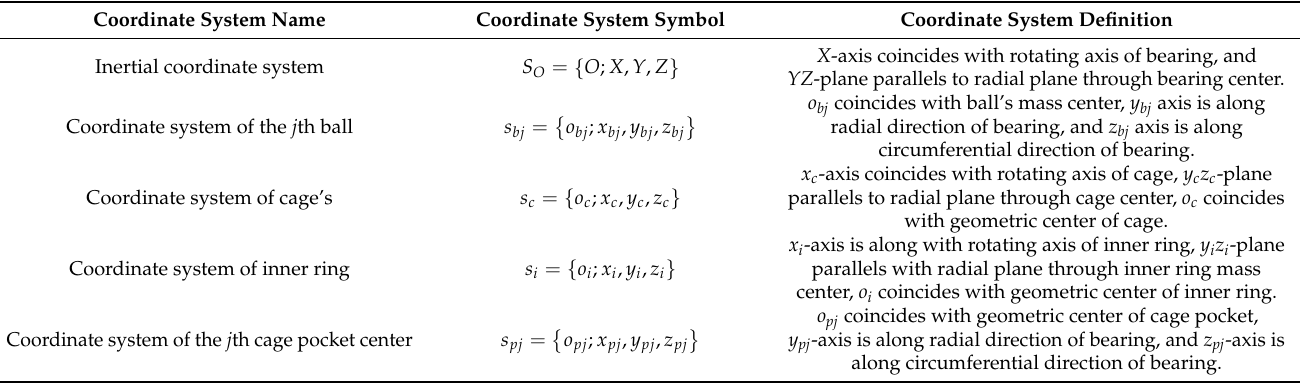
Figure 5. Coordinate systems of the ball bearings. Table 2. Definitions of the coordinate systems.